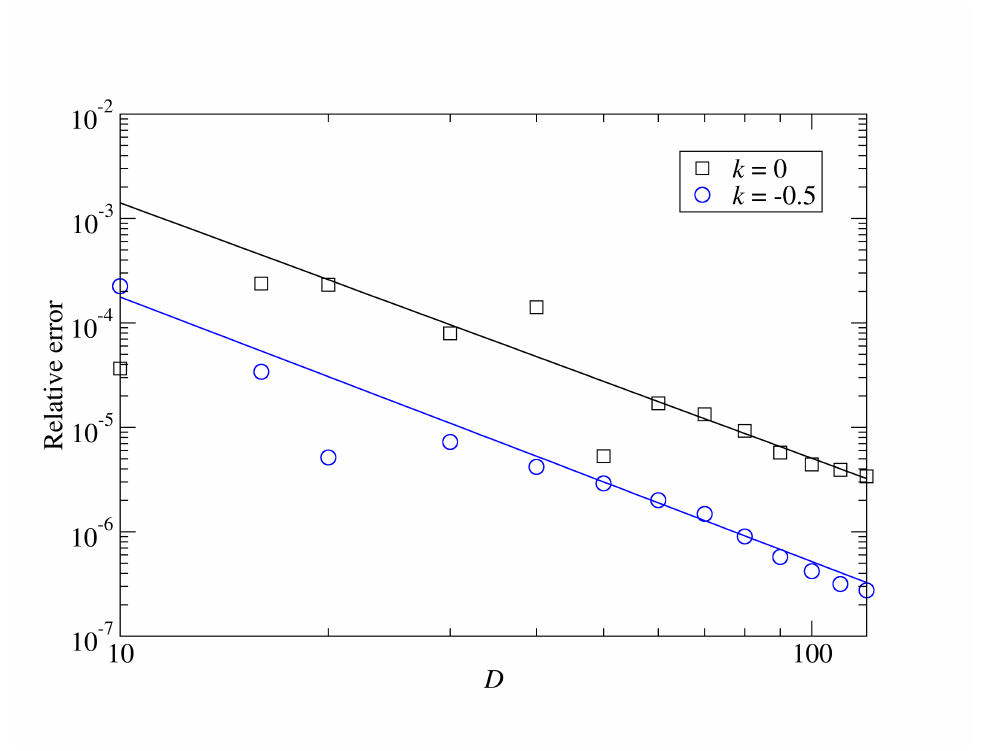
Figure 5 . Relative error of the free energy as a function of the bond dimension D . The system size is 2 20 . The solid lines show the fitting function aD − 2 κ , where a and κ are fit parameters. Note that k = 0 corresponds to the Grassmann Levin-Nave TRG and k = − 0 . 5 does to the Grassmann BTRG. The fit ranges are set to be D ∈ [60 , 120] for k = 0 and D ∈ [50 , 120] for k = − 0 . 5 , because the Grassmann BTRG yields more stable results for smaller D than the Grassmann Levin-Nave